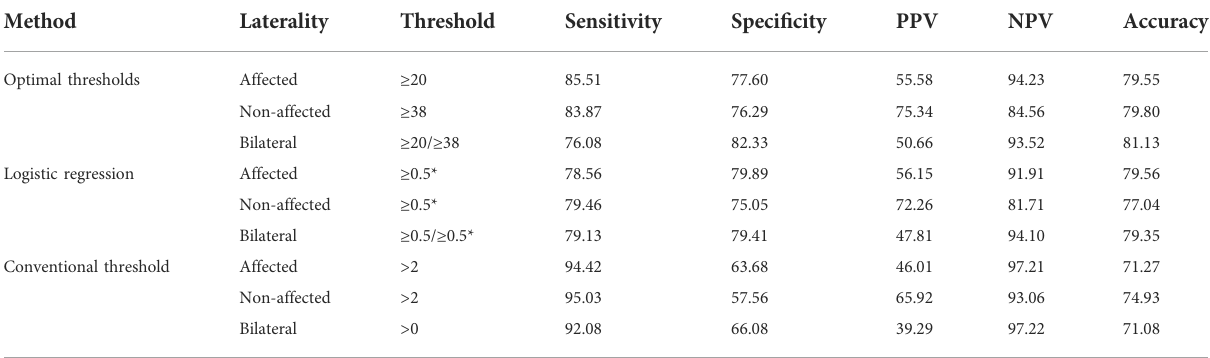
TABLE 3 Classi fi cation performance across